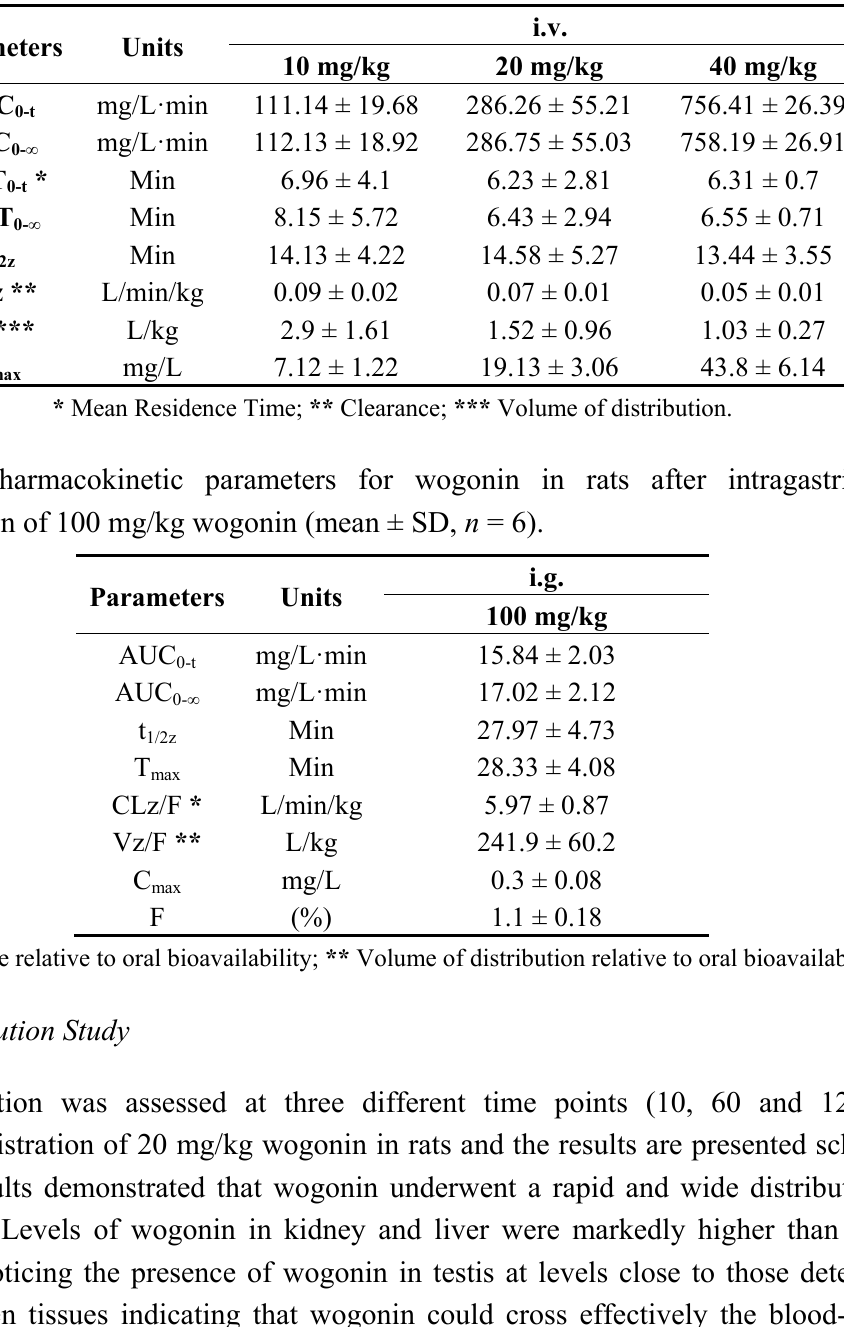
Table 1. Pharmacokinetic parameters for wogonin in rats after intravenous (i.v.) administration of wogonin at different dose levels (mean ± SD, n = 6).